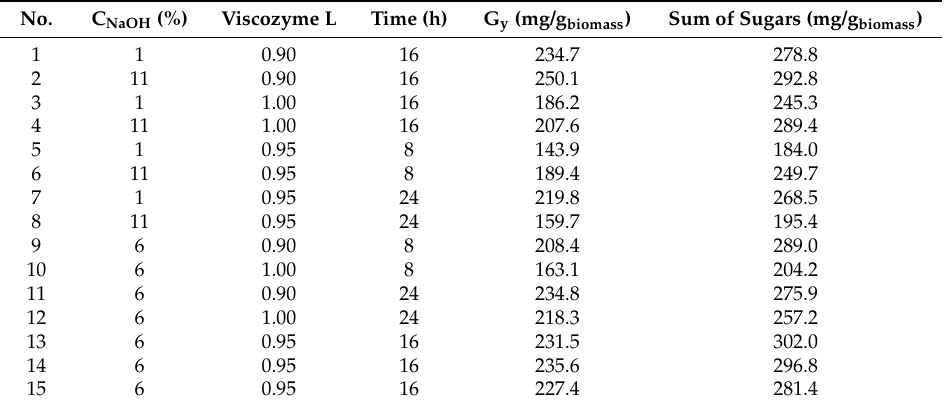
Table 5. Box-Behnken design for alkaline pre-treatment and enzymatic hydrolysis of Triticum sp. No. C NaOH (%) Time (h) G y (mg/g biomass